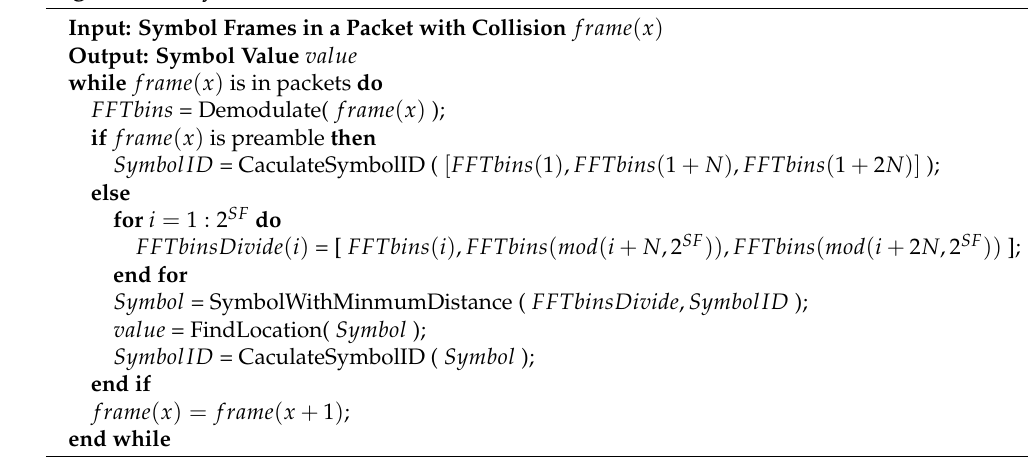
Algorithm 2 Symbol Classification and